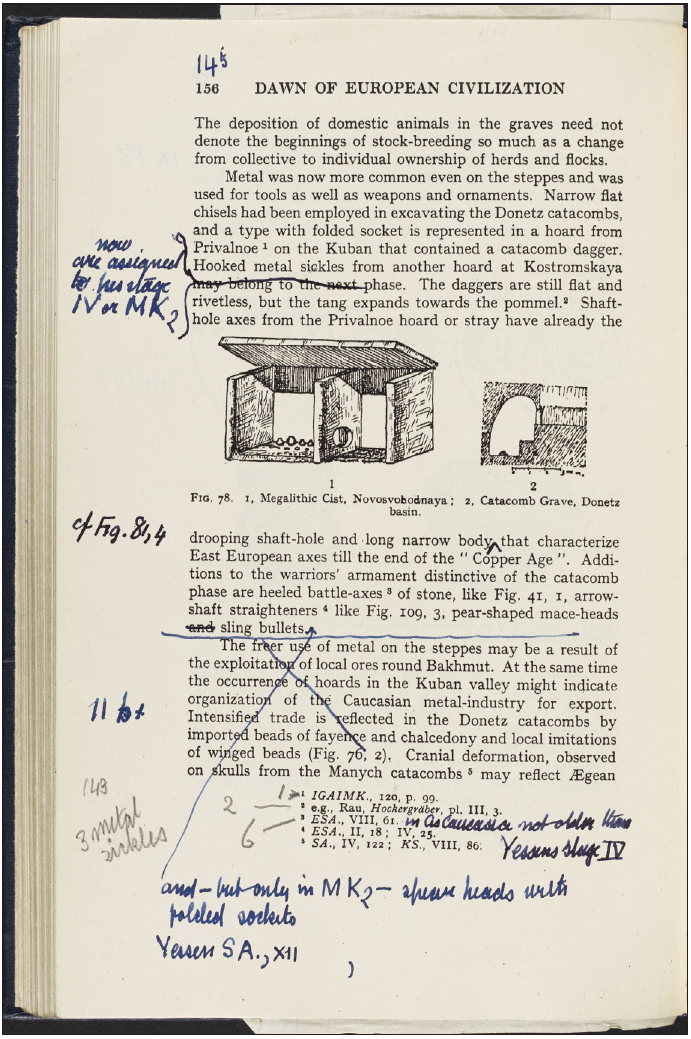
Figure 4: Page of Childe’s own copy of the fifth edition of The Dawn used as a ‘proof’ for his revisions for the sixth edition of. 1955–57. (Photo UCL Library